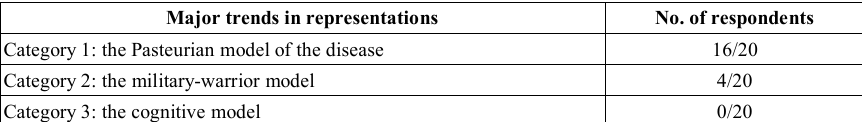
Table 1. Categories of students’ representations of the concept of immunity Major trends in